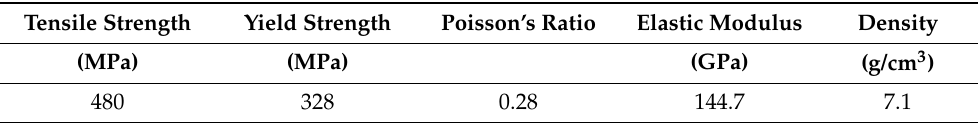
Table 2. Mechanical properties of ductile cast iron